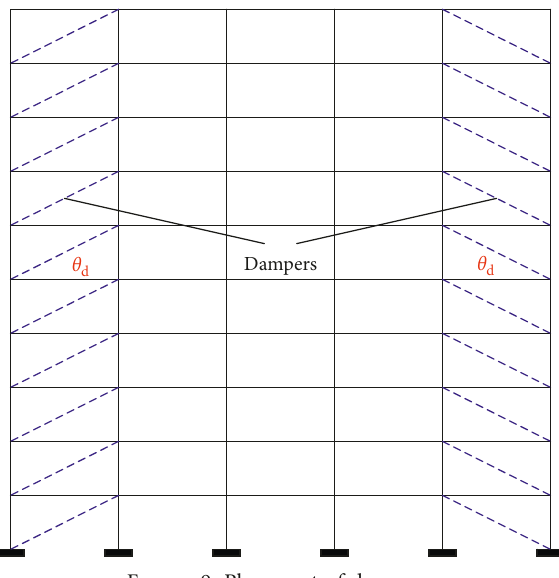
Figure 9: Placement of